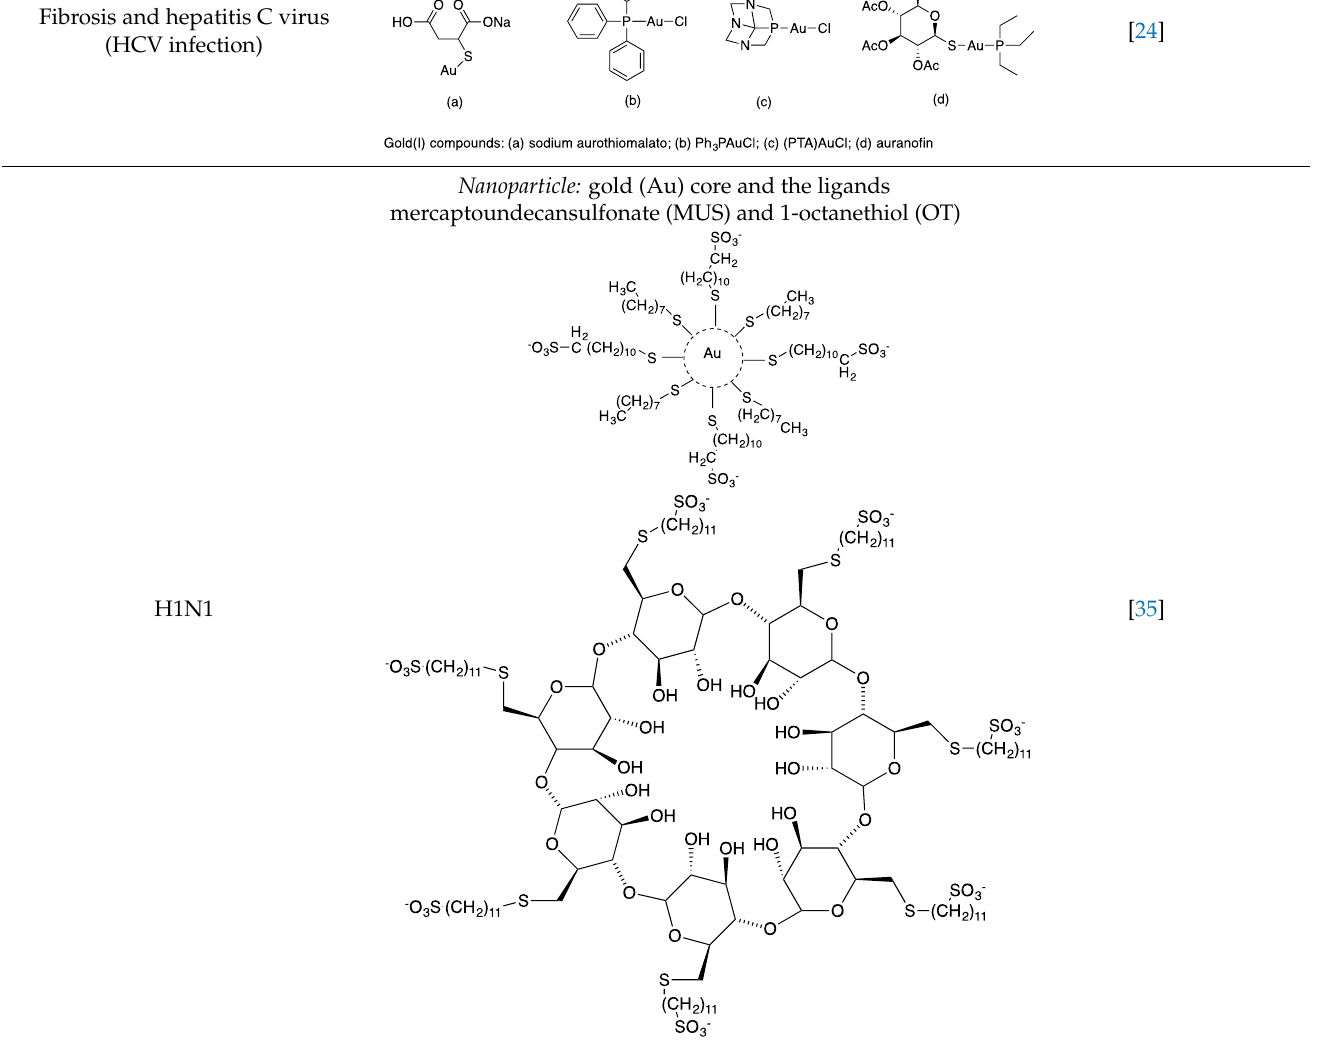
Fibrosis and hepatitis C virus (HCV infection)